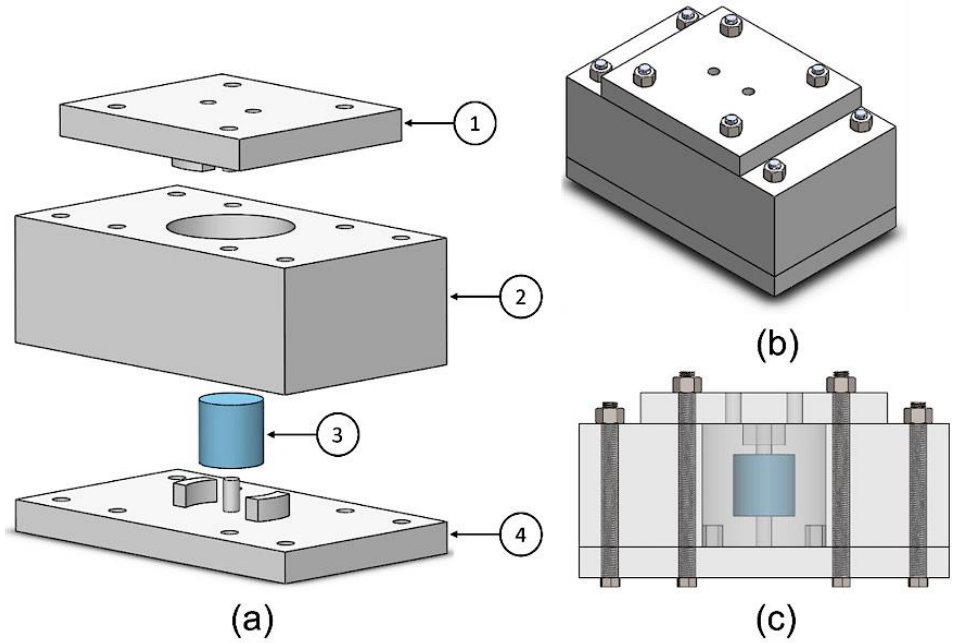
Figure 3. Hybrid MRE material mold design; ( a ) exploded view: 1—upper plate; 2—middle plate; 3—Styrofoam piece; 4—lower plate. ( b ) Isometric view of the assembled mold. ( c ) Front view showing the position of the Styrofoam inside the mold.